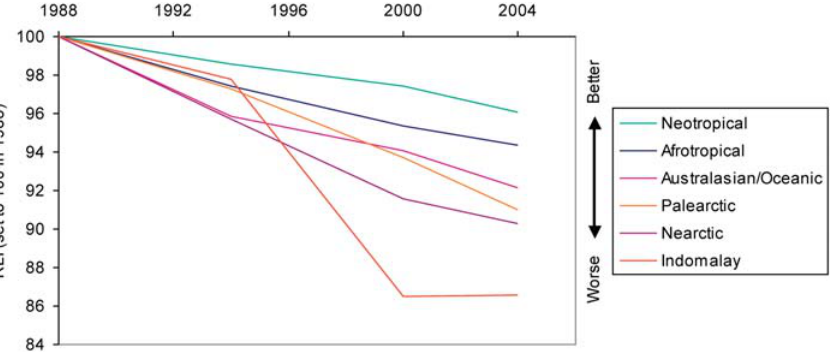
Figure 4. RLIs for Birds in Different Biogeo- graphic Realms Sample sizes: Neotropical, 49 genuine status changes/834 species in categories Extinct in the Wild to Near Threatened in at least one assessment; Afrotropical, 41/394; Australasian/Oceanic, 53/614; Pa- learctic, 34/238; Nearctic, 9/92;